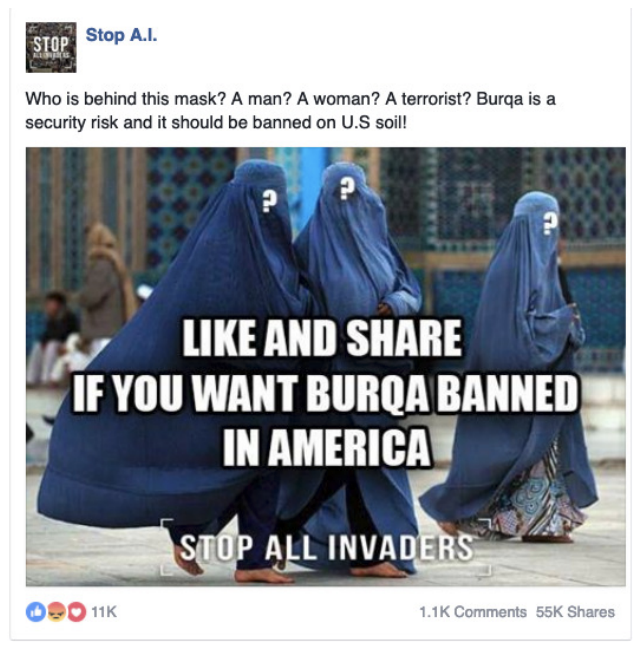
Figure 1. Russian created meme, 2016. Source: U.S. House of Representatives Permanent Select Committee (2018). Media and Communication, 2022, Volume 10, Issue 4, Pages